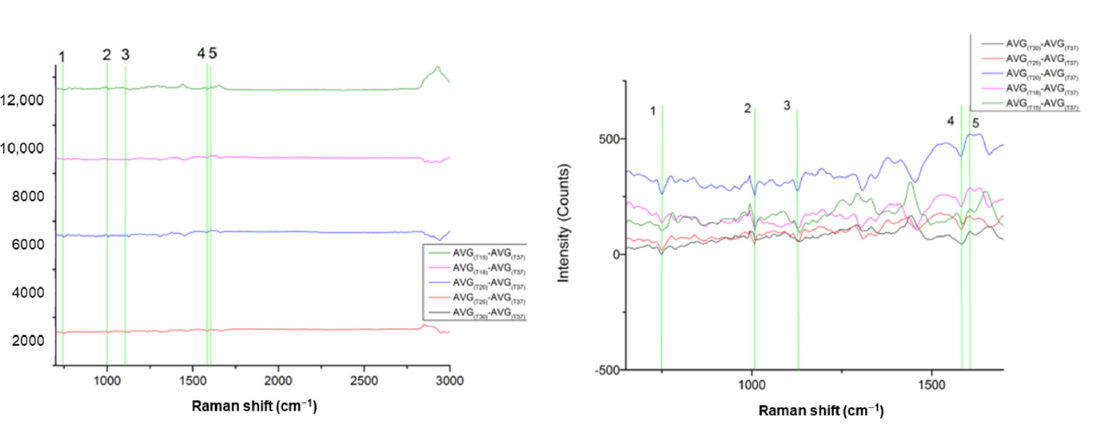
Figure 6. ( left ) Raman signal differences due to temperature (Tn-T37 plot); ( right ) Magnification of Raman signal differences.